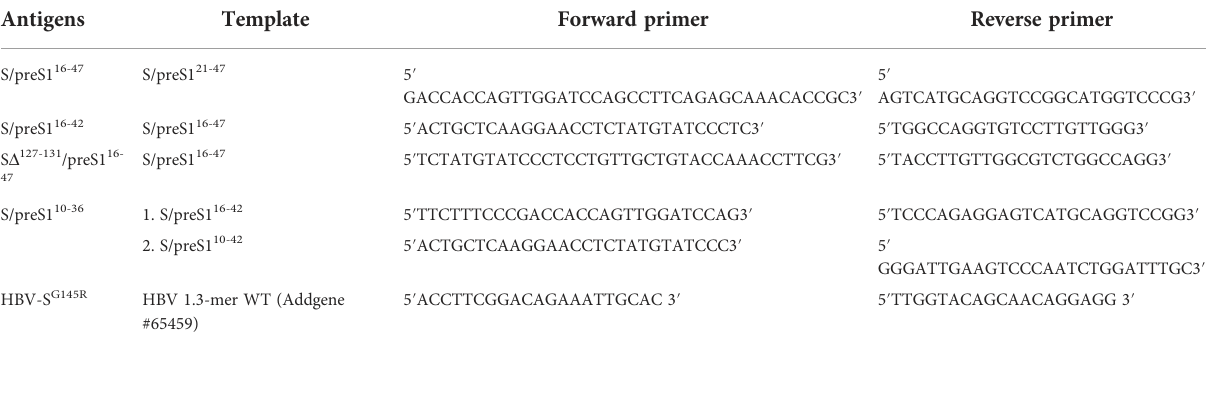
TABLE 1 Templates and primers used to generate the novel S/preS1 antigens and the HBV vaccine-escape mutant.